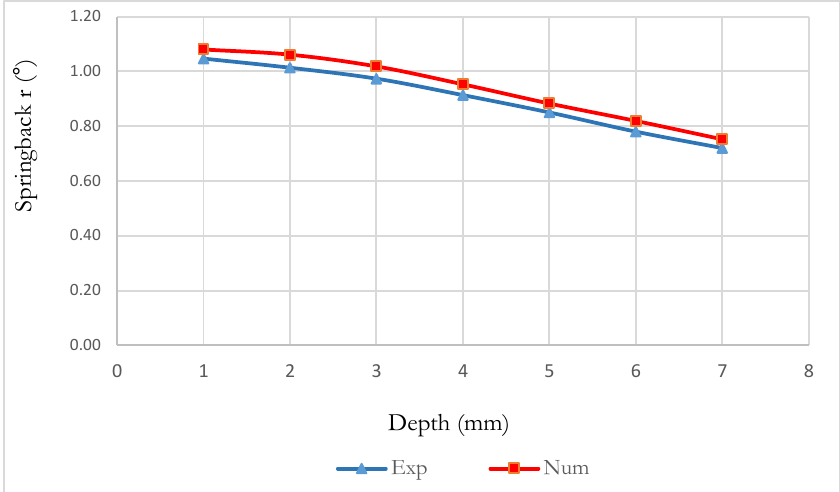
Fig. 11. Comparison of the results for the thickness of 1.5 mm.